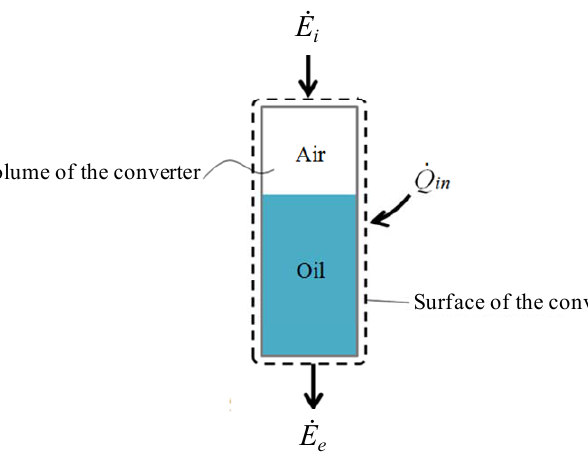
Figure 4. The energy balance of the